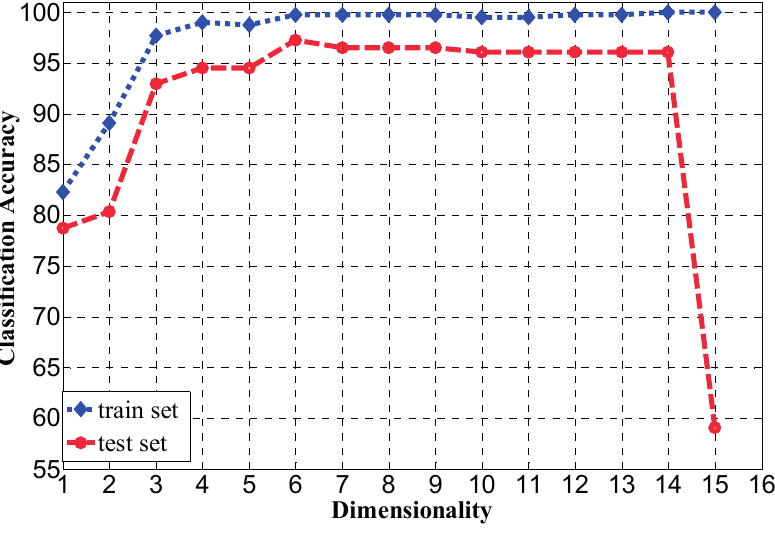
Figure 8. Classification accuracy according to the increased feature